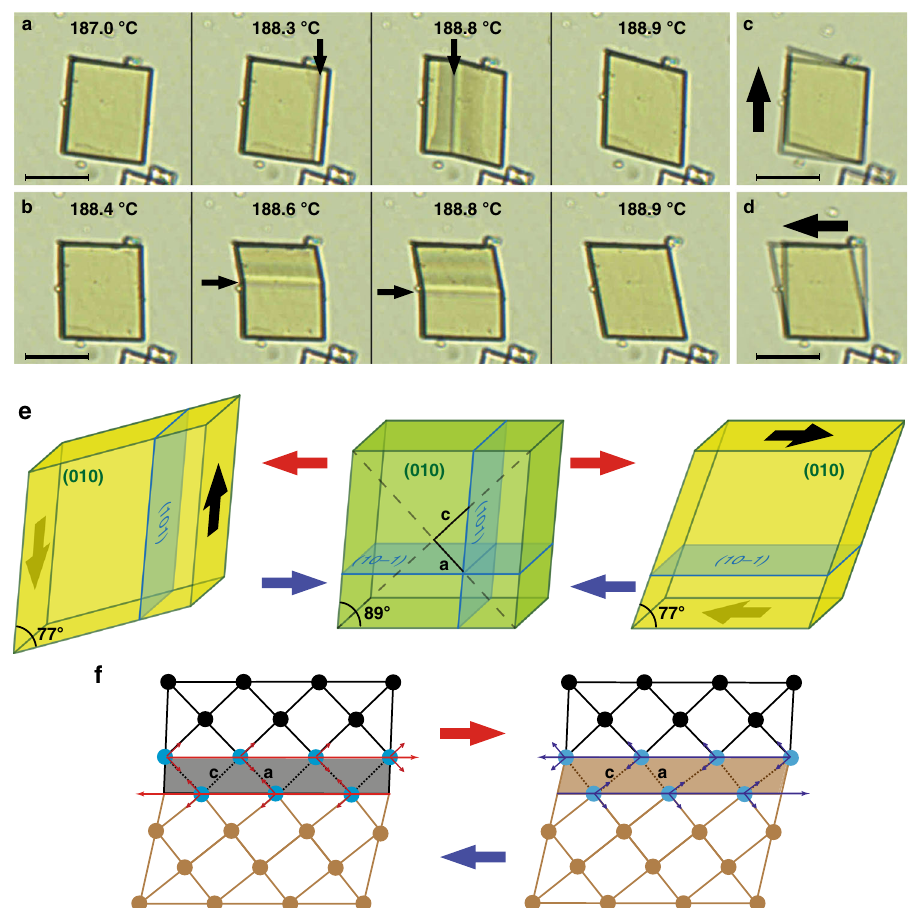
Fig. 2 Two directions of shape deformation during the phase transition. a , b Optical microscope images show that the temperature dependent shape deformation from the α - to β -phase can proceed in two independent directions. The position of the phase boundary is indicated with black arrows. c , d Overlapped microscope images of the same crystal before and after the phase transition, showing that the crystal orientations relate to the direction of the phase boundaries. The arrows indicate the corresponding shear directions. Scale bar is 20 μ m. e Schematic presentations of the corresponding crystallographic planes and the shear directions (black arrows). The blue planes indicate the possible directions of the phase boundaries, which are parallel to the (101) or (10-1) plane. f Schematic presentations of the origin of the shear force and its relation to the shrinking/contraction ( a -axis) and contraction/shrinking ( c -axis) in the (010 ) plane during heating (short red arrows)/cooling (short blue arrows). The black and the gray grids represent the lattices of the α -phase and the β -phase, respectively. The long red and blue arrows show the shear forces that result in the migration of the phase boundary during heating and cooling,